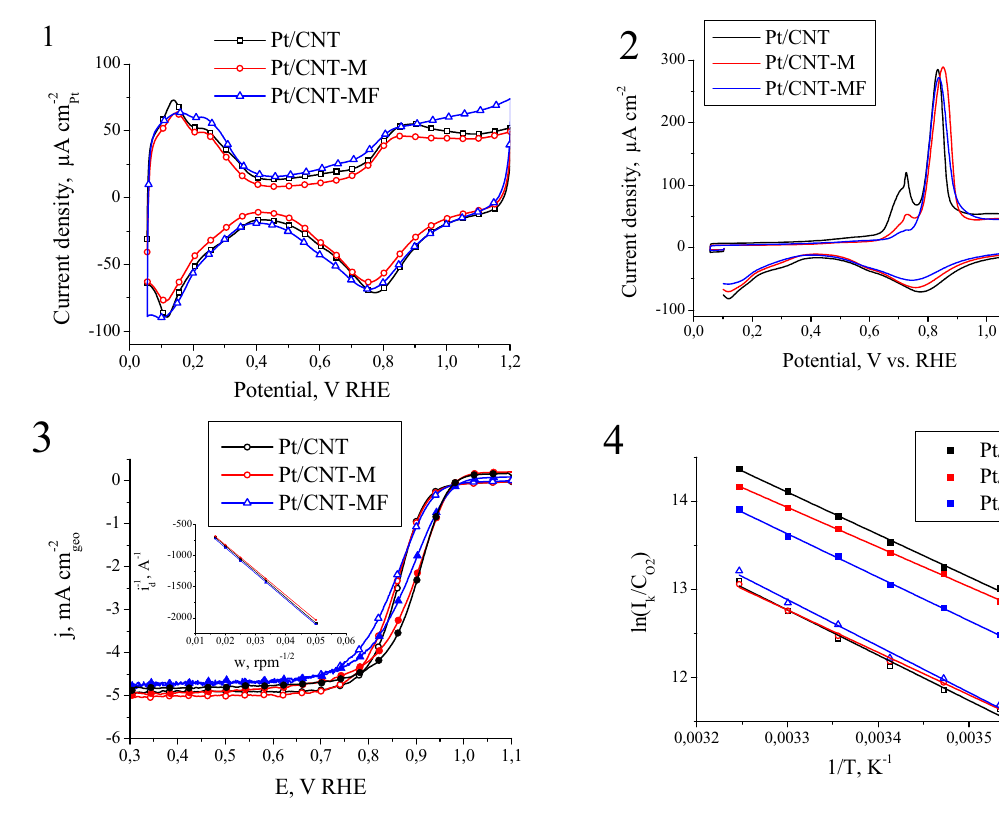
opened symbols, inset—Koutecky–Levich plots for Pt/C catalysts; 4 Arrhenius plot obtained at 0.9 V ( η = − 0.329 V) for anode (closed symbols) and cathode (open symbols) scans. Electrolyte 0.1 M HClO 4 , T = 25 °C